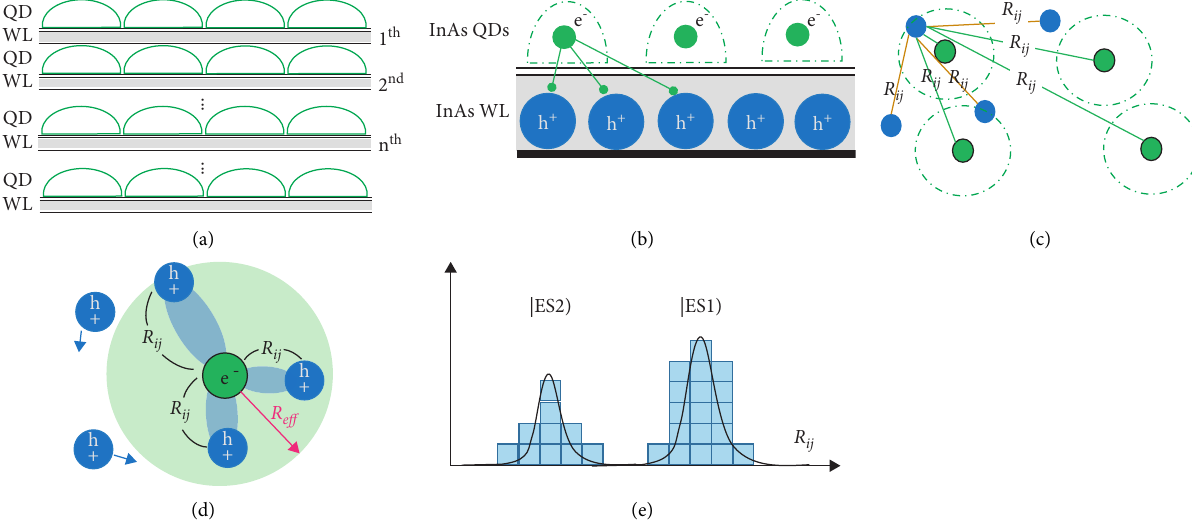
Figure 2: (a) Multilayer of high-density InAs QDs/GaAsSb ensemble; (b) Excitonic distribution model where electrons are localized in QD while holes are itinerant within the WL layer; (c) Coupling distance distribution among e- and h + ; (d) Schematic illustration of the effective coupling radius R eff ; and (e) Histogram of distance between e-and h + .